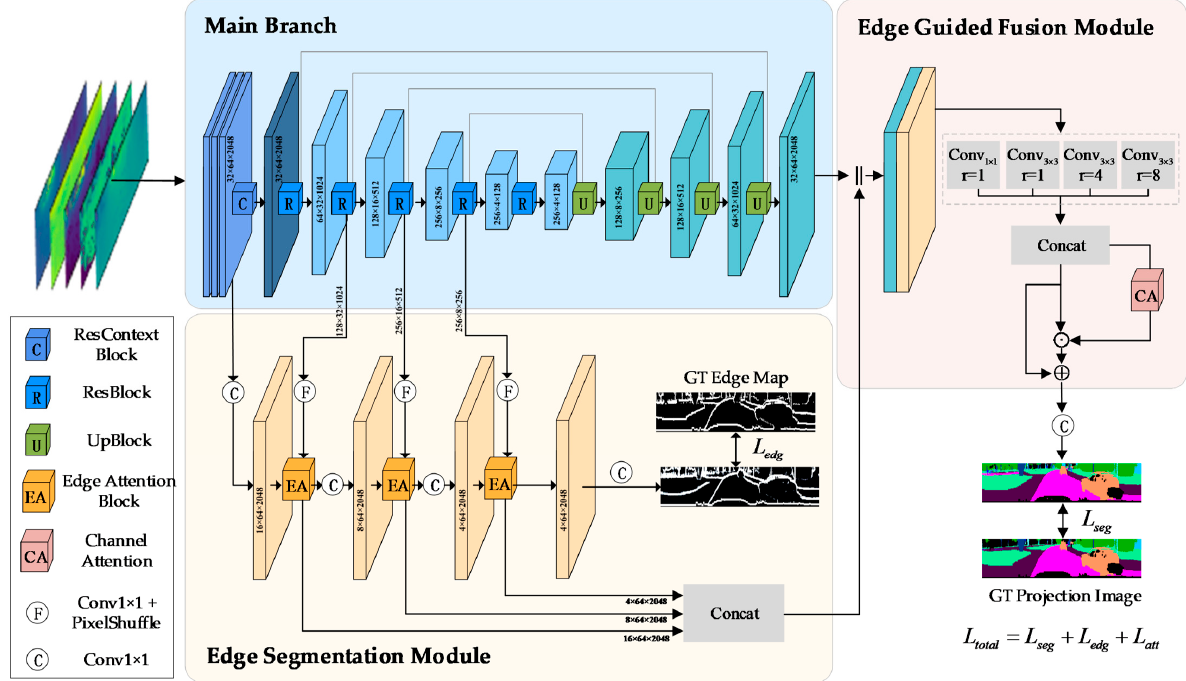
Figure 1. The architecture of our network.